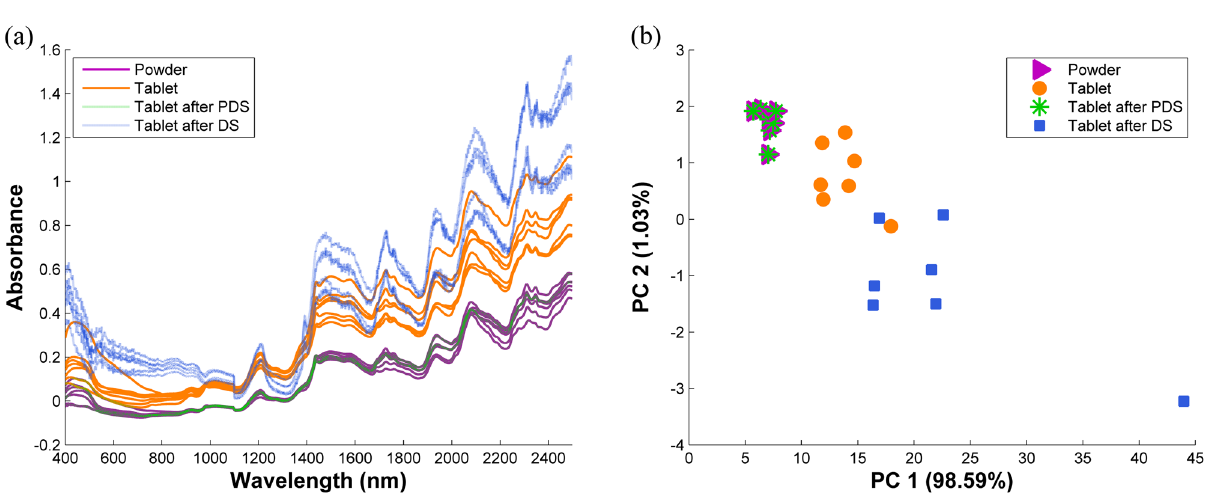
Figure 2. ( a ) NIR spectra of the test milk samples (powder and tablet) and ( b ) PCA score plot of the milk samples after the DS and PDS